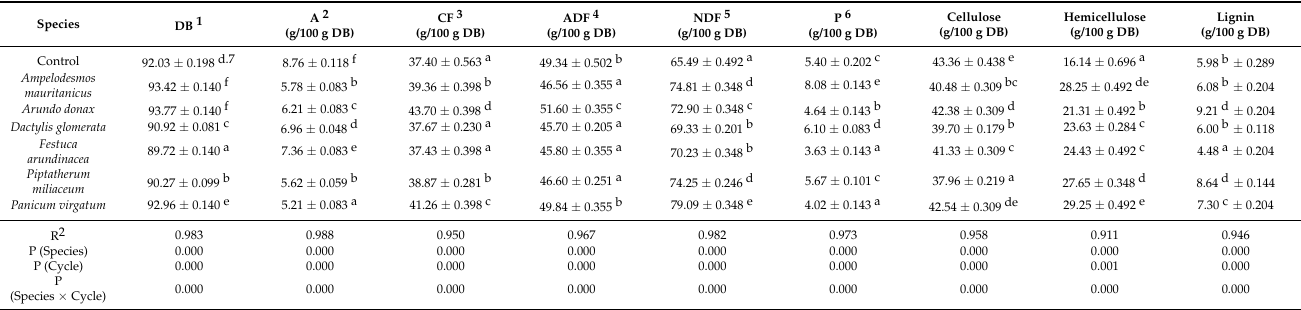
Table 5. Bromatology analysis of the different perennial grasses